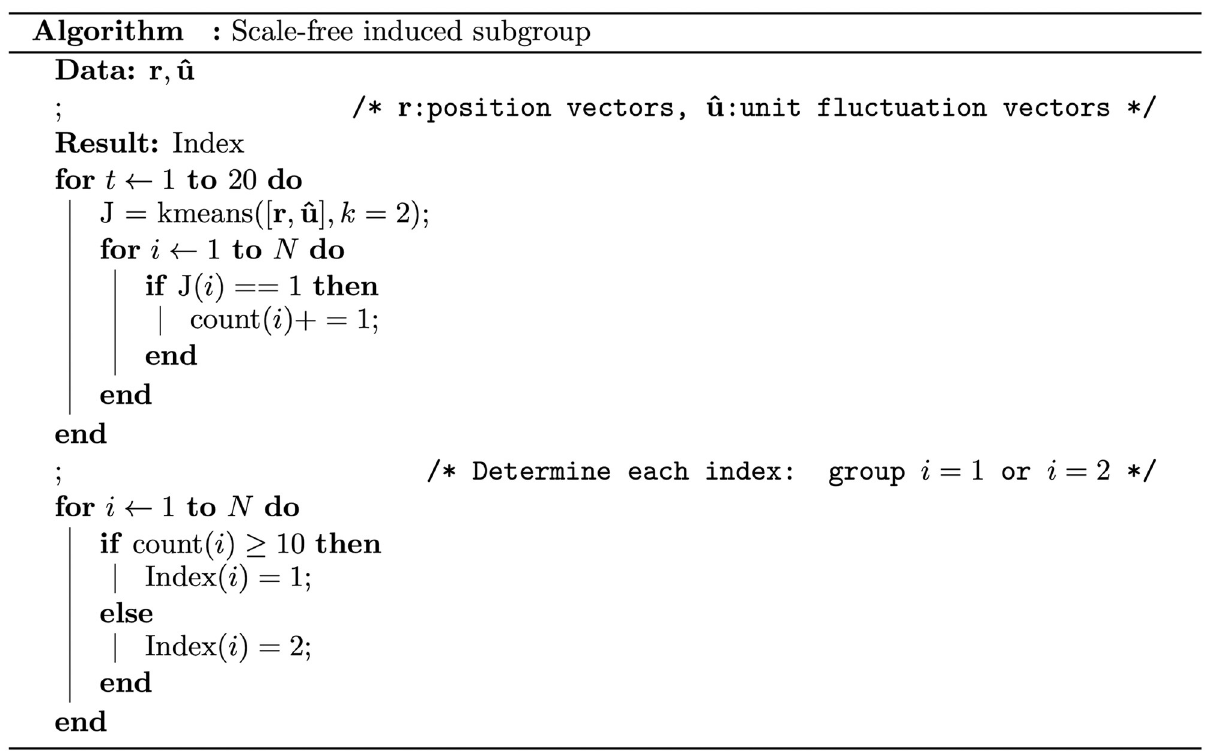
Fig 8. Algorithm of the scale-free induced subgroup. The input information is f r information). The output index is the assignment group number.